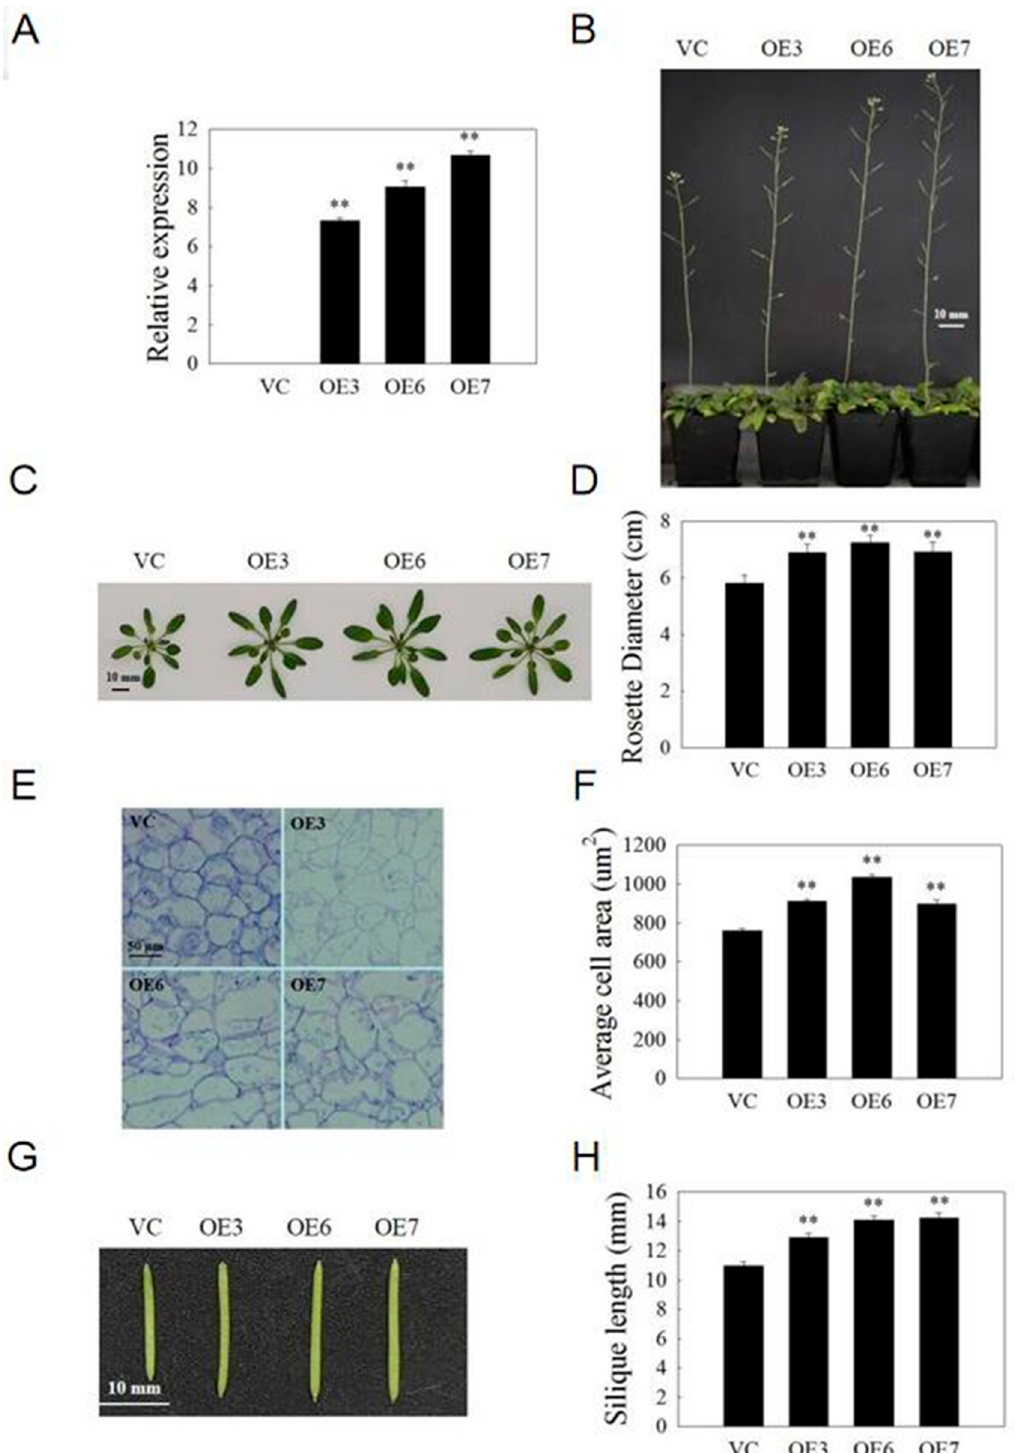
Figure 8. VvSAUR041 promotes seedling growth and cell expansion of Arabidopsis . ( A ) Transcription level of VvSAUR041 in OE and VC transgenic Arabidopsis based on RT-qPCR. ( B ) Phenotype of main inflorescence stem at stage 6. ( C ) Rosette leaf phenotype of 4-week-old Arabidopsis . ( D ) Rosette diameter of Arabidopsis in lower panel. ( E ) Third leaf section of 3-week-old Arabidopsis . ( F ) Average cell area of 3-week-old Arabidopsis . ( G ) Phenotype of silique. ( H ) Length of silique. Asterisks indicate a significant difference (** p < 0.01).